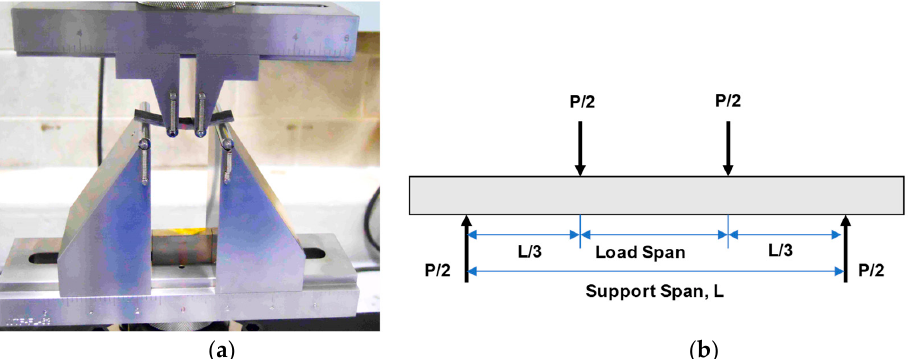
Figure 5. Four point flexural test ( a ) test fixture with sample; ( b ) schematic of the one third of the support span test setup according to ASTM D6272.